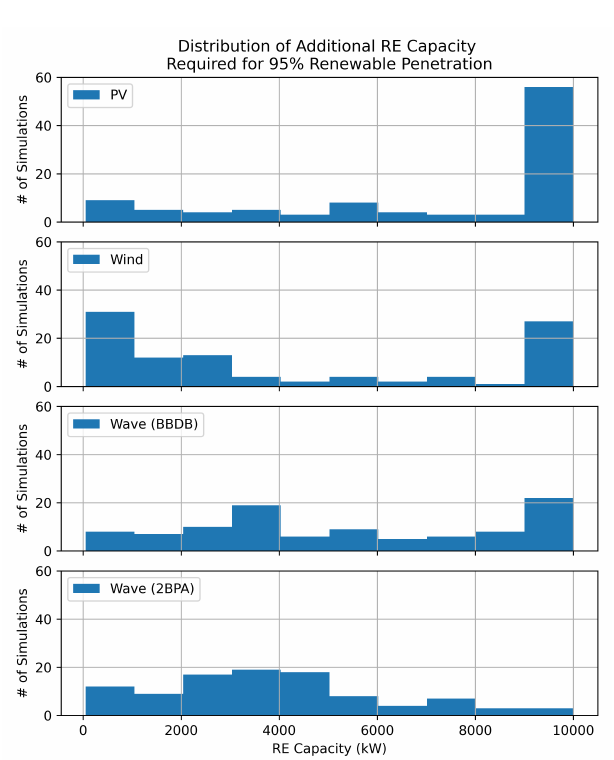
Fig. 2. The distribution of required additional renewable energy capacity required for the baseline system to achieve 95% zero- emission generation across 100 simulations. A required capacity of 10 MW indicates that the maximum number of iterations was reached before the system could meet the zero-emission generation threshold.